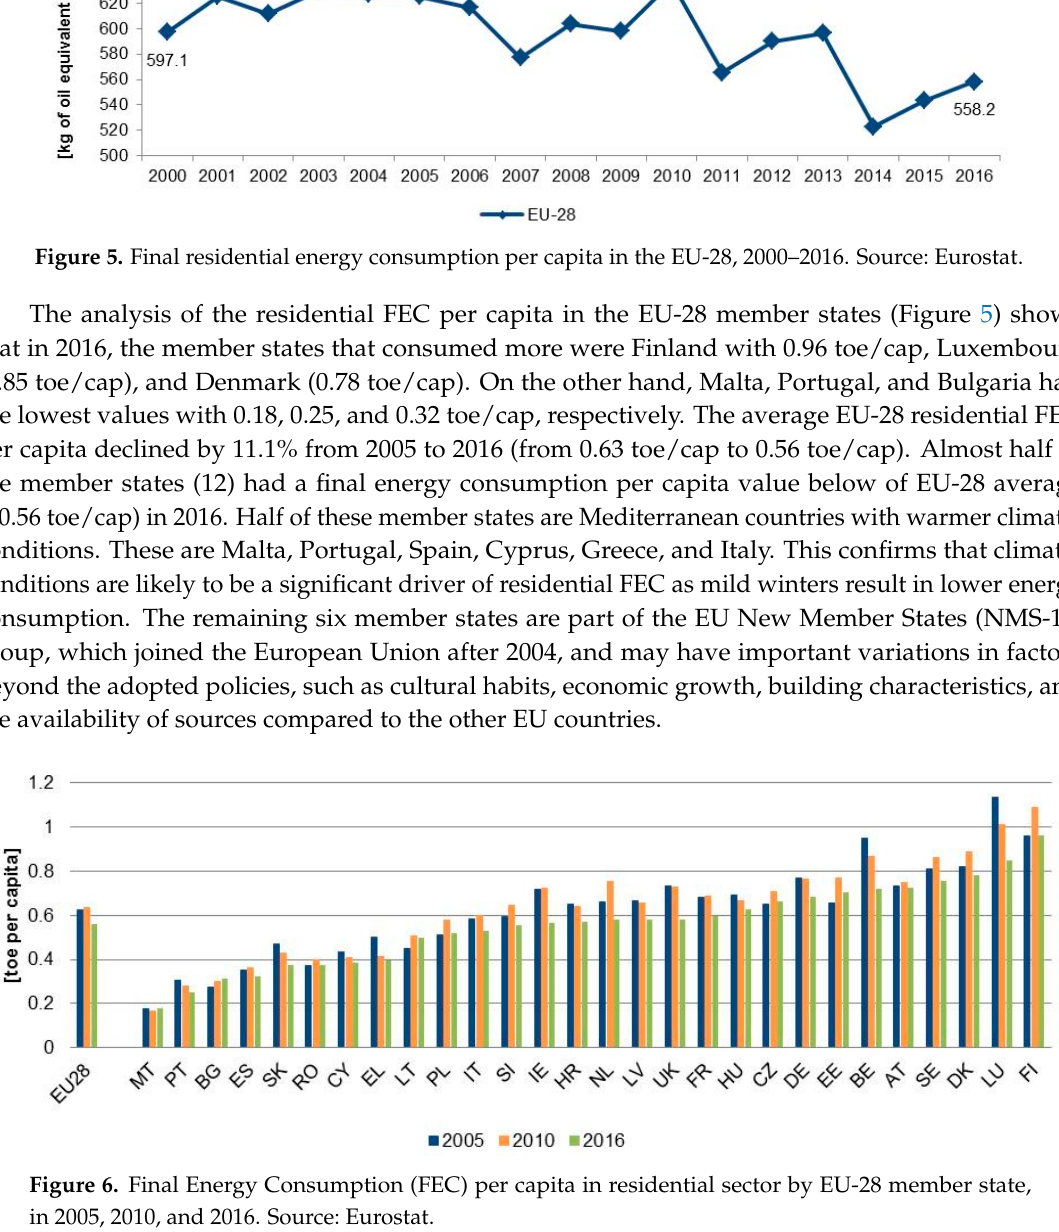
Figure 4. Population in the EU-28, 2000–2016. Source: Eurostat.